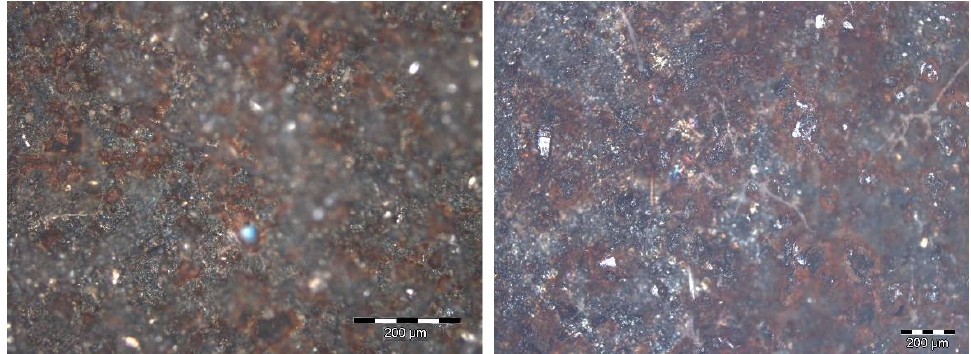
Figure 12. Micrographs at different magnifications of the surface estate of the C1 coating after 720 h of exposure to combined aging presenting ferric pits along the whole exposed surface.